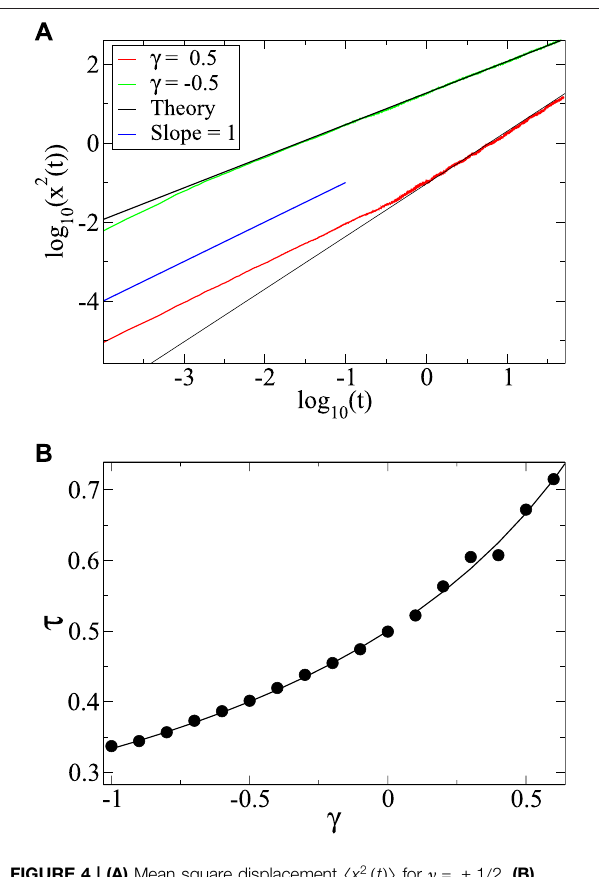
FIGURE 4 | (A) Mean square displacement 〈 x 2 ( t ) 〉 for c (cid:2) ± 1 / 2. (B) The corresponding diffusion exponent ( (cid:129) ) compared to the prediction of Eq. 6 (full line) for the range of γ -values where the integral of Eq. 39